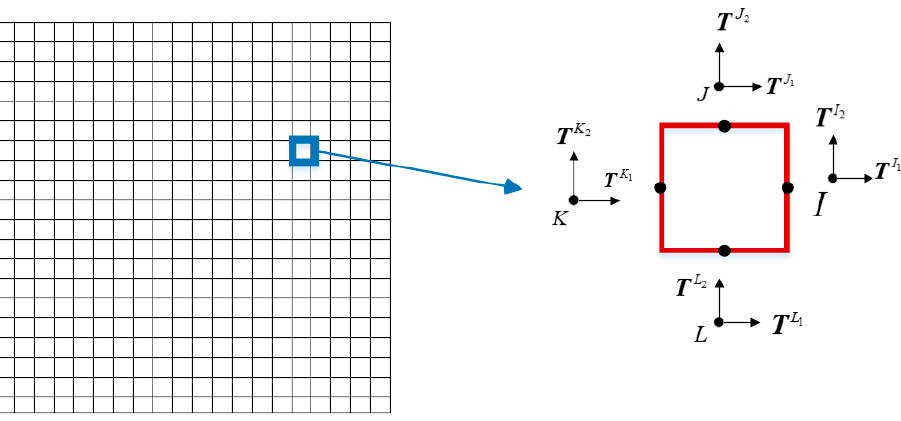
Figure 3. Mesh subsection